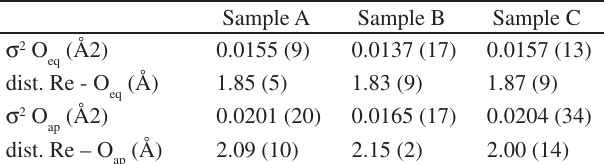
Table 2. Results from the EXAFS analysis for the first and second coordina- tion shells: O are the equatorial oxygens (in the basal plane) and O eq apical ones (in the 00l direction) 4 . Sample